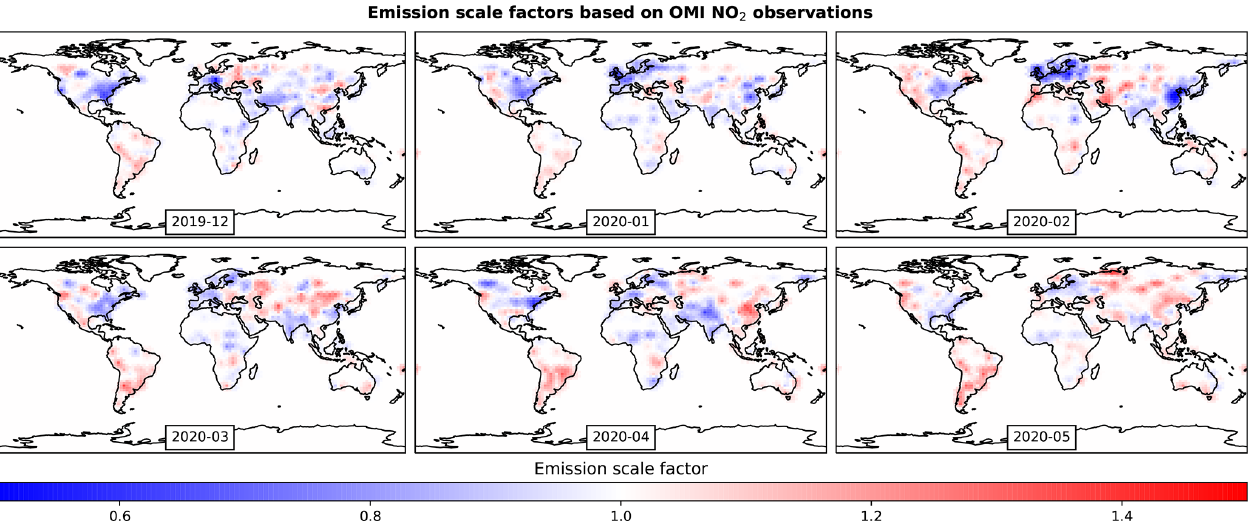
Figure A14. Emission scale factors used for model sensitivity simulation. Shown are the monthly average perturbations applied to the GEOS-CF anthropogenic base